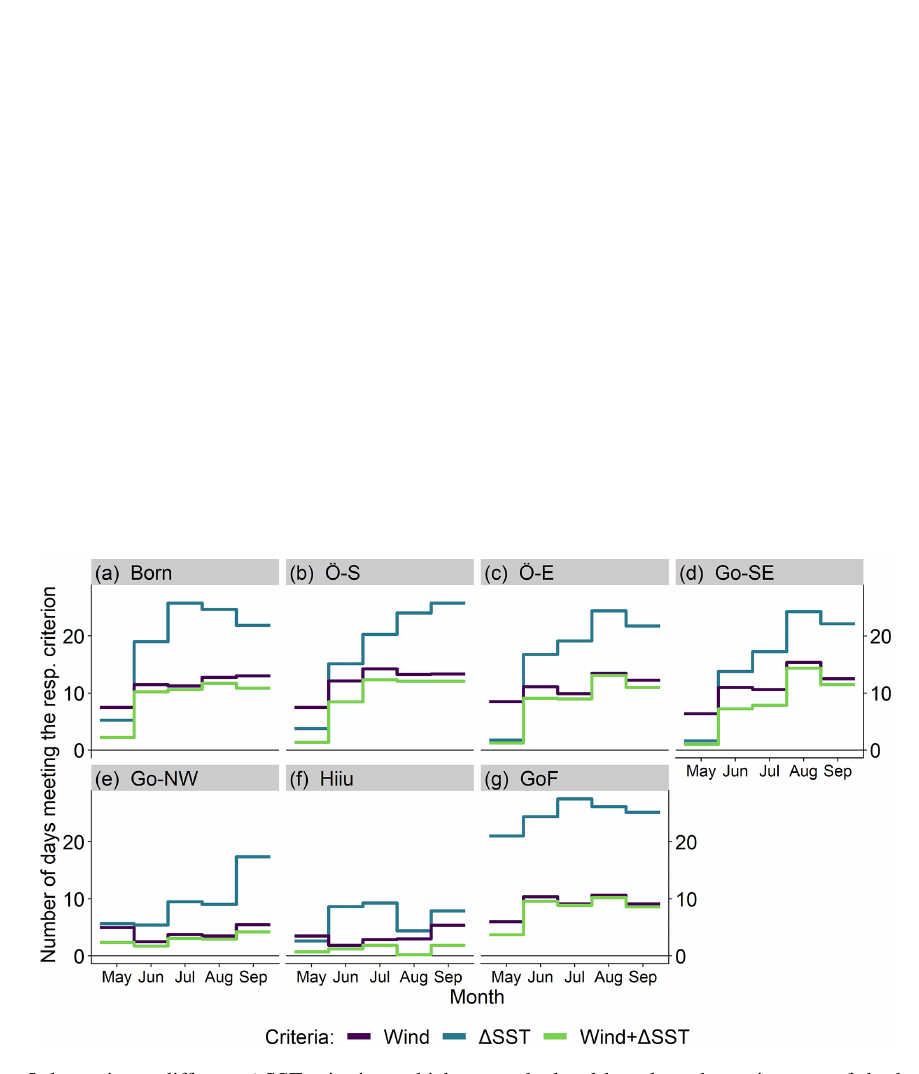
Figure B3. As Fig. 5, but using a different (cid:49) SST criterion, which was calculated based on the entire area of the boxes (Sect. 2.3; first